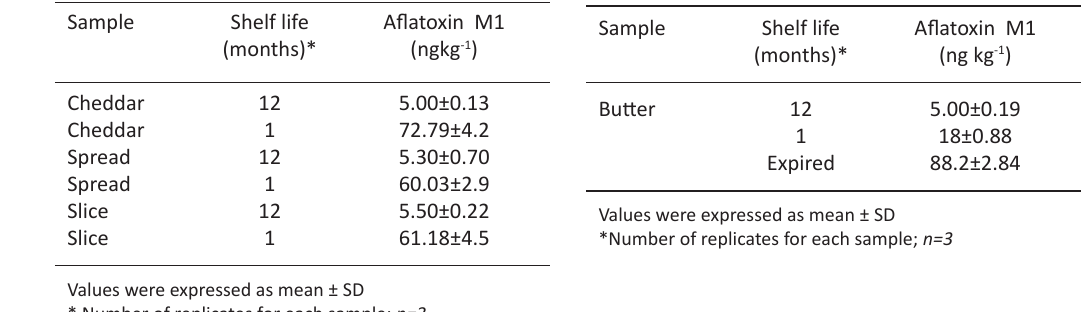
Table 4. Level of aflatoxin M1 in butter with different duration of expiry